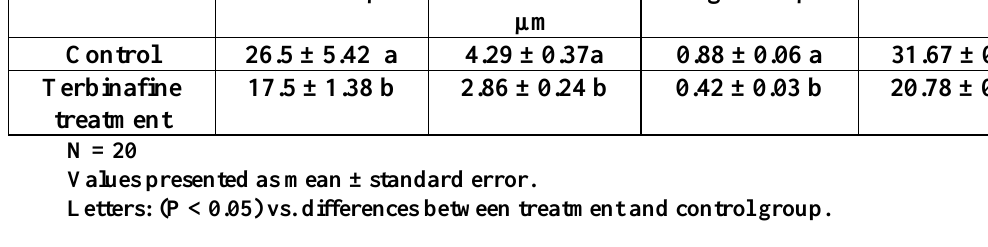
Table (3) effect of terbinafine on ovarian atretic follicles number Groups